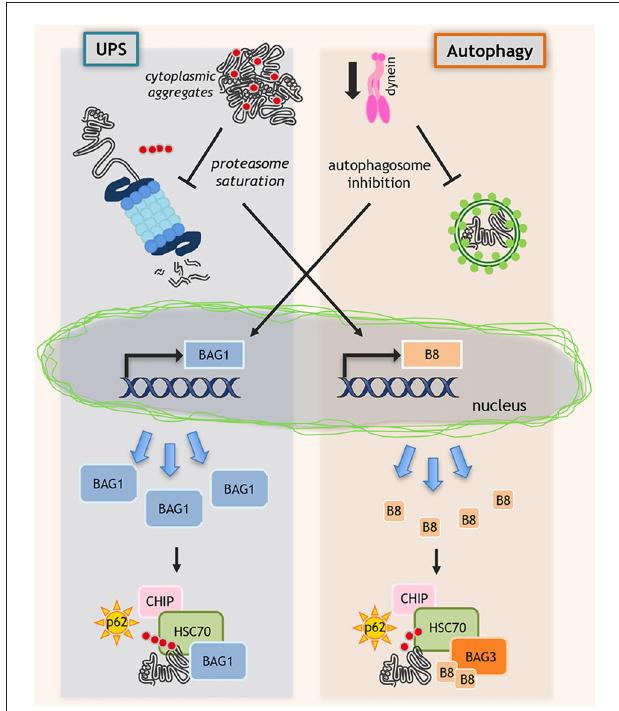
FIGURE 2 | Regulation of protein quality control (PQC) system. When misfolded proteins cannot be efficiently removed by degradative pathways, misfolded proteins may accumulate and block ubiquitin proteasome system (UPS) and autophagy. In this context, proteasome saturation by misfolded proteins increases the transcription of HSPB8 (B8 in the figure) that, together with its partners BAG3 and HSC70, routes misfolded proteins to autophagy. In parallel, when dynein-mediated transport is blocked and autophagosomes formation is inhibited, still unknown factors activate the de novo transcription of BAG1, which binds to HSP70/CHIP and routes misfolded proteins to